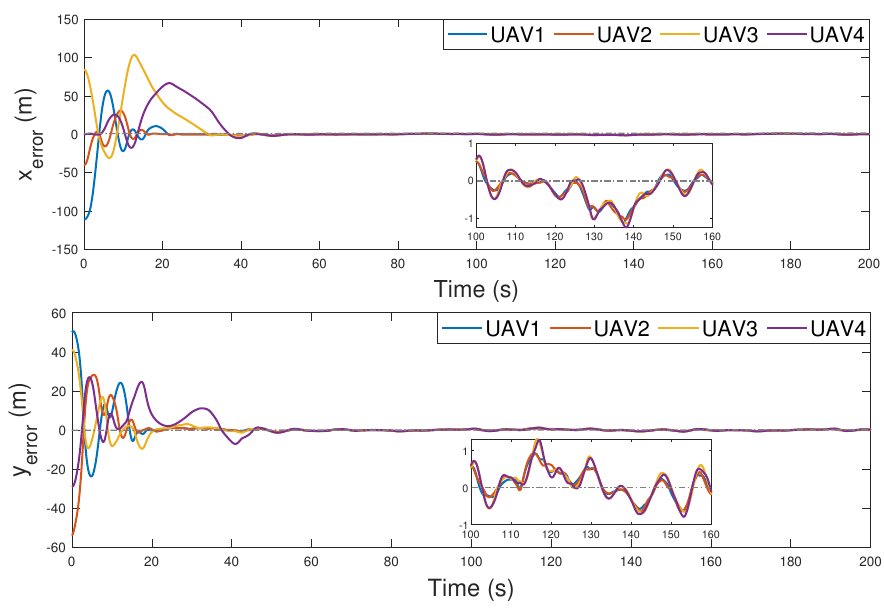
Figure 6. Consensus tracking error of four